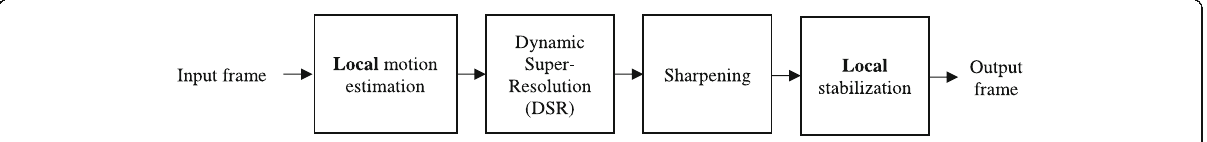
Fig. 2 Flow diagram of the proposed method for dynamic turbulence mitigation under medium turbulence conditions (0.2 < r 0 /D <